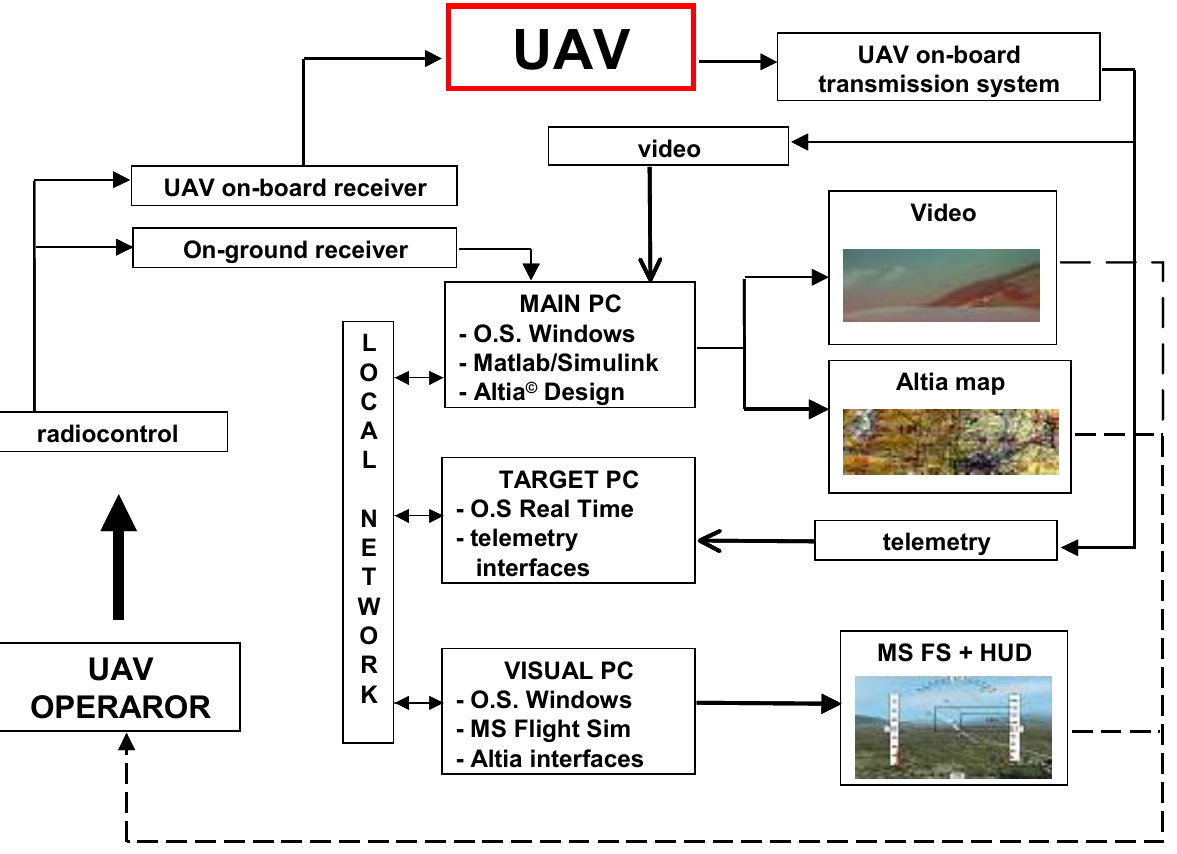
Fig 8. Prospective hypothetical system configuration integrated with real